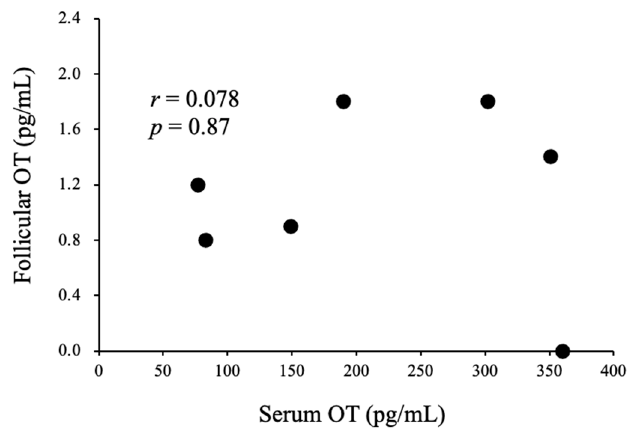
Figure 4. Correlations between serum OT levels on the day of the hCG trigger and follicular OT levels in infertile women during IVF/ICSI cycles.